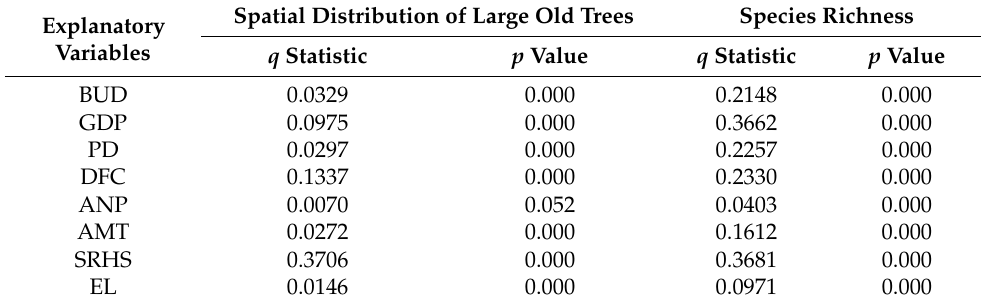
Table 4. Factor detection